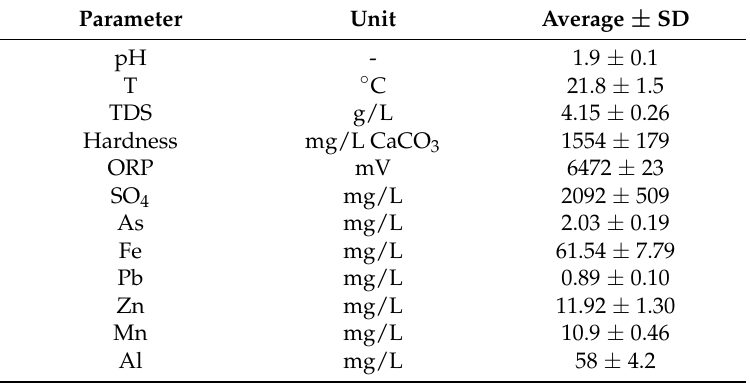
Table 1. Main characteristics of the synthetic water. Number of measurements =